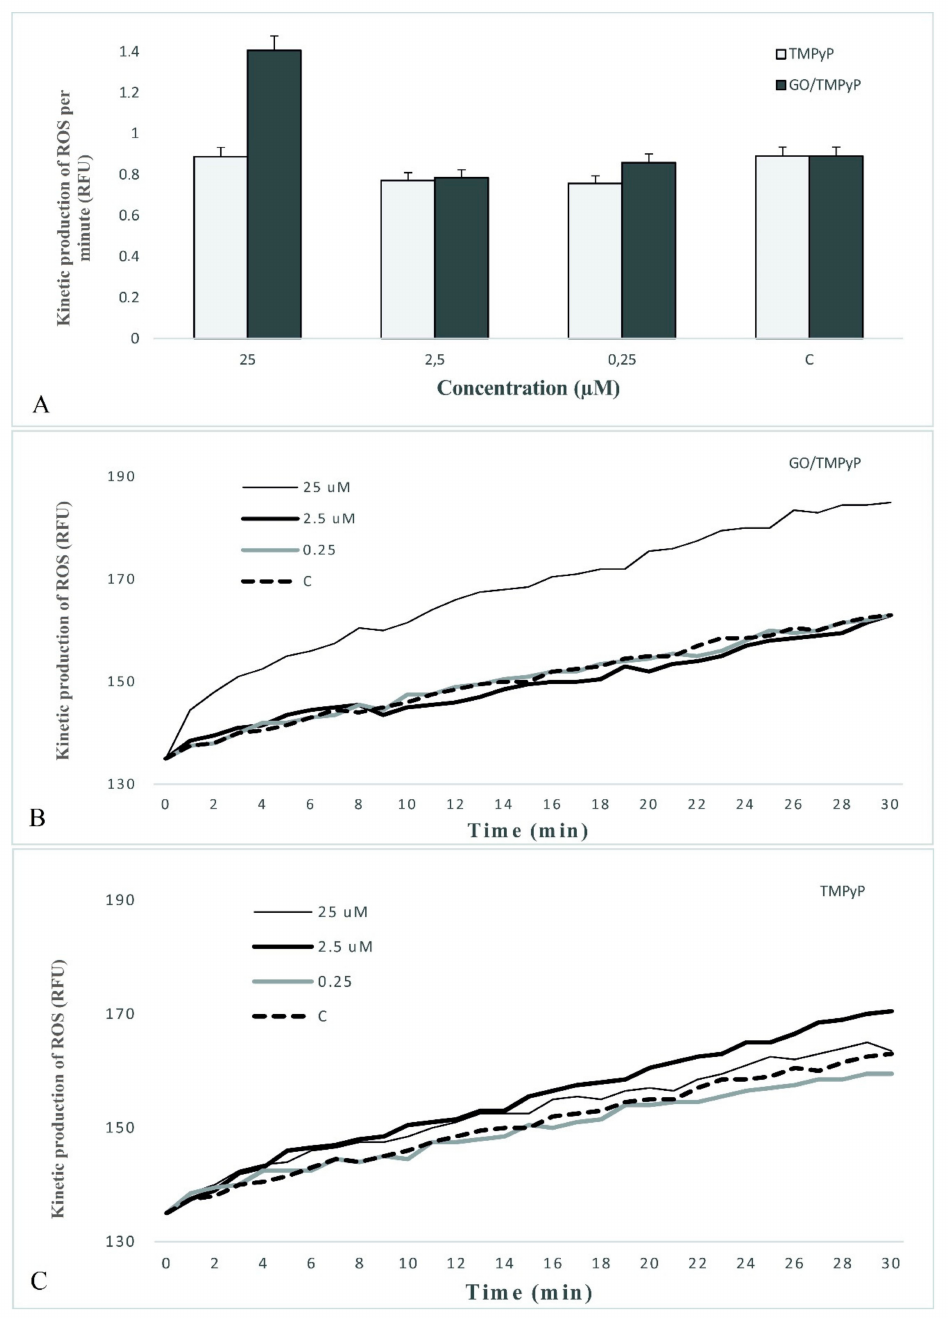
Figure 7. Kinetic production of reactive oxygen species in concentrations of 0.25 µ M, 2.5 µ M, and 25 µ M of TMPyP ( A , C ) or GO / TMPyP ( A , B ) nanocarrier on the HeLa cell line. Notes: The linear regression of the reactive oxygen species (ROS) rate expressed the ROS amount created at each minute. Data represent mean and standard error from three independent